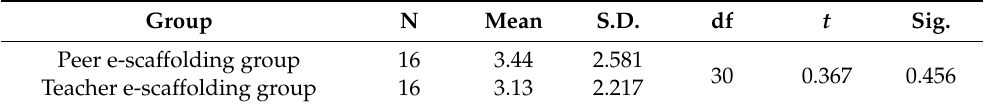
Table 3. Independent-samples t -test of the skills pre-assessment. Group N Mean S.D. df t Sig. Peer e-scaffolding group